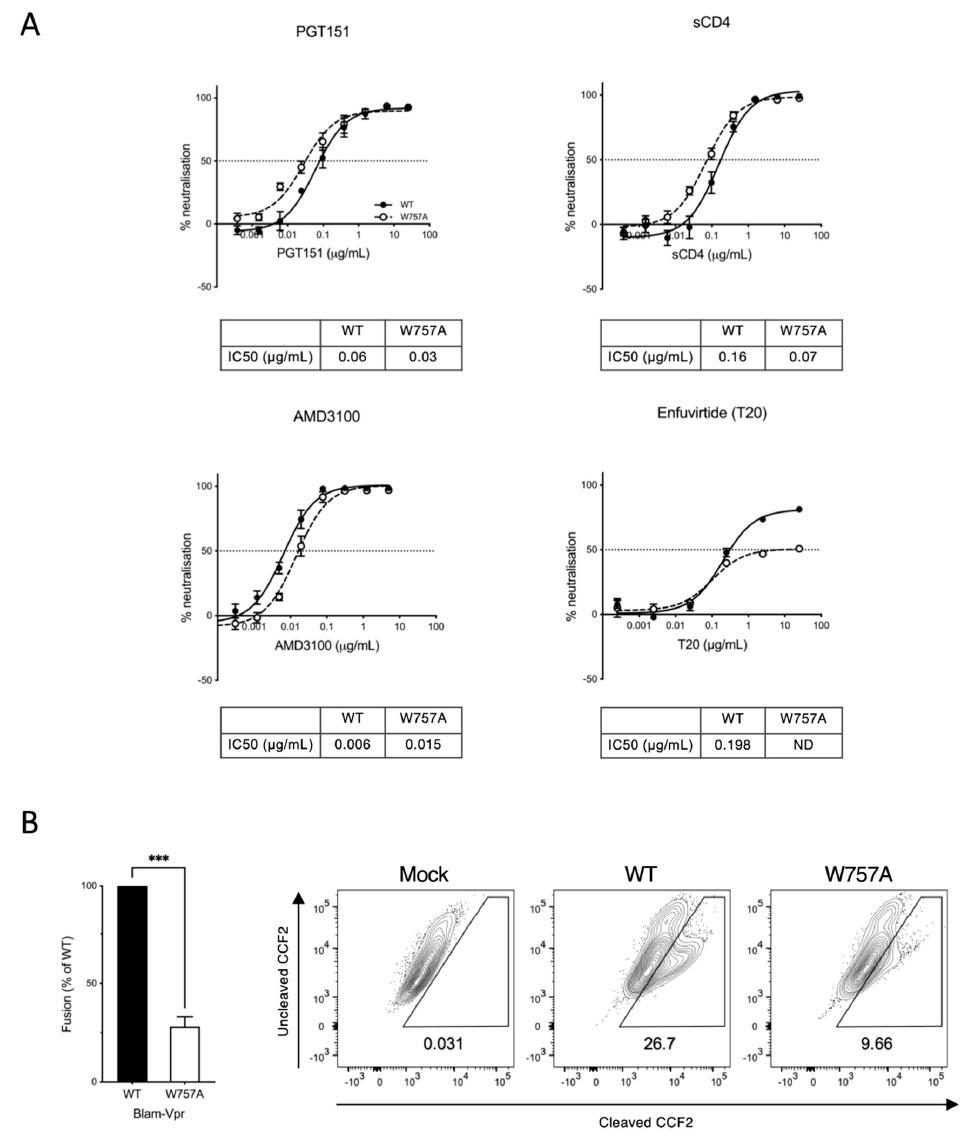
Figure 6. W757A virus shows a defect in viral fusion. ( A ) Neutralisation of WT and W757A virus (produced from Jurkat T cells) by PGT151 bNAb, sCD4, AMD3100 and T20 by neutralisation assay using HeLa TZM-bl cells. IC 50 values calculated by nonlinear regression analysis of the neutralisation curves. ND denotes not determined. ( B ) W757A Env is defective in viral fusion compared to WT virus as measured by the BlaM-Vpr fusion assay. Data are the mean and SEM compared using an unpaired t ‐ test (*** p < 0.001). Mock refers to co ‐ culture between uninfected T cells and target T cells.